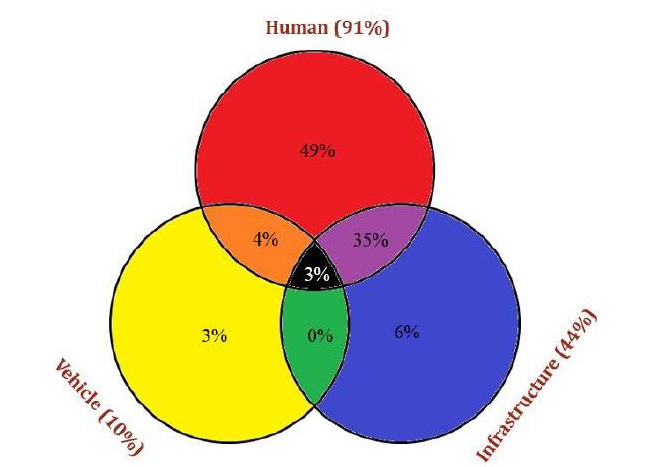
Fig. 3. Distribution of 211 Accidents by Contributing Factors influencing the Occurrence of